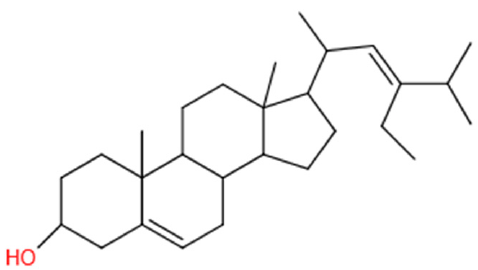
Figure 1. Chemical structure of stigmasterol.